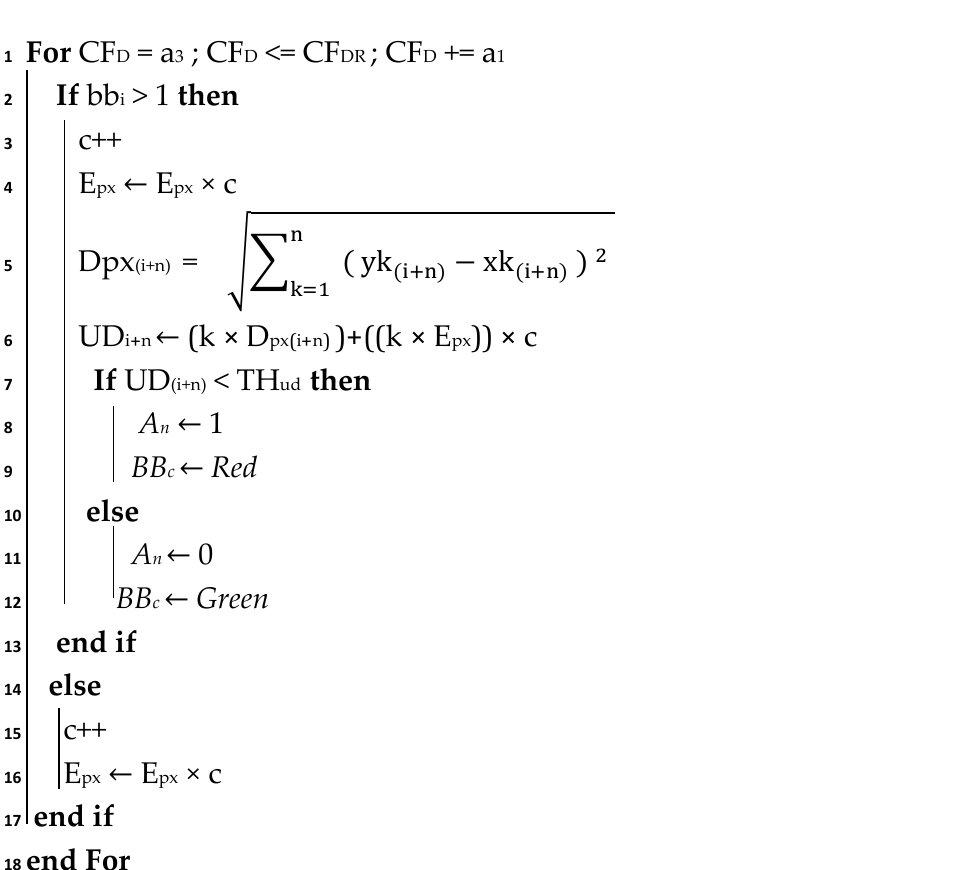
Figure 5. Workflow of the DepTSol model. 5. Experiments & Results 5.1. Experimental Setup We performed transfer-learning on the MS COCO dataset [49] to train a custom ob- ject detector to attain the highest model accuracy. The selection of hyper-parameters for the training of one stage object detectors on the ExDARK dataset were as follows: The network size was 512 × 512. The initial learning rate was 0.01. The initial batch size was 64 with 16 subdivisions. To accelerate gradients vectors in the right directions, stochastic